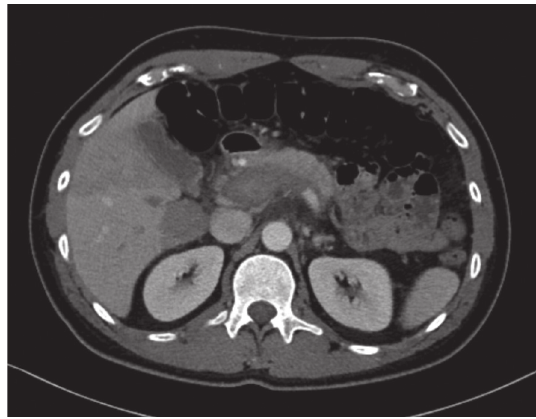
Figure 1: CT scan of abdomen/pelvis showing portal vein thrombosis.